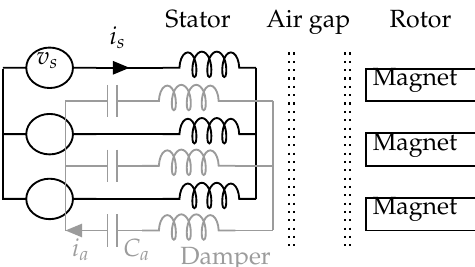
Figure 2. Representation of the damper winding.